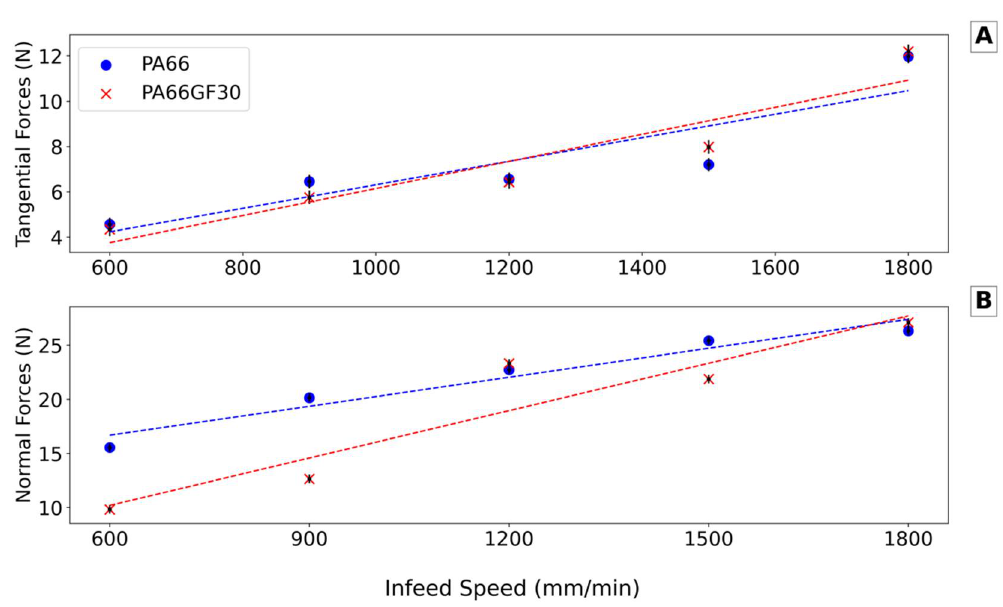
Figure 2. ( A ) Measured tangential forces F t and ( B ) measured normal force F n .